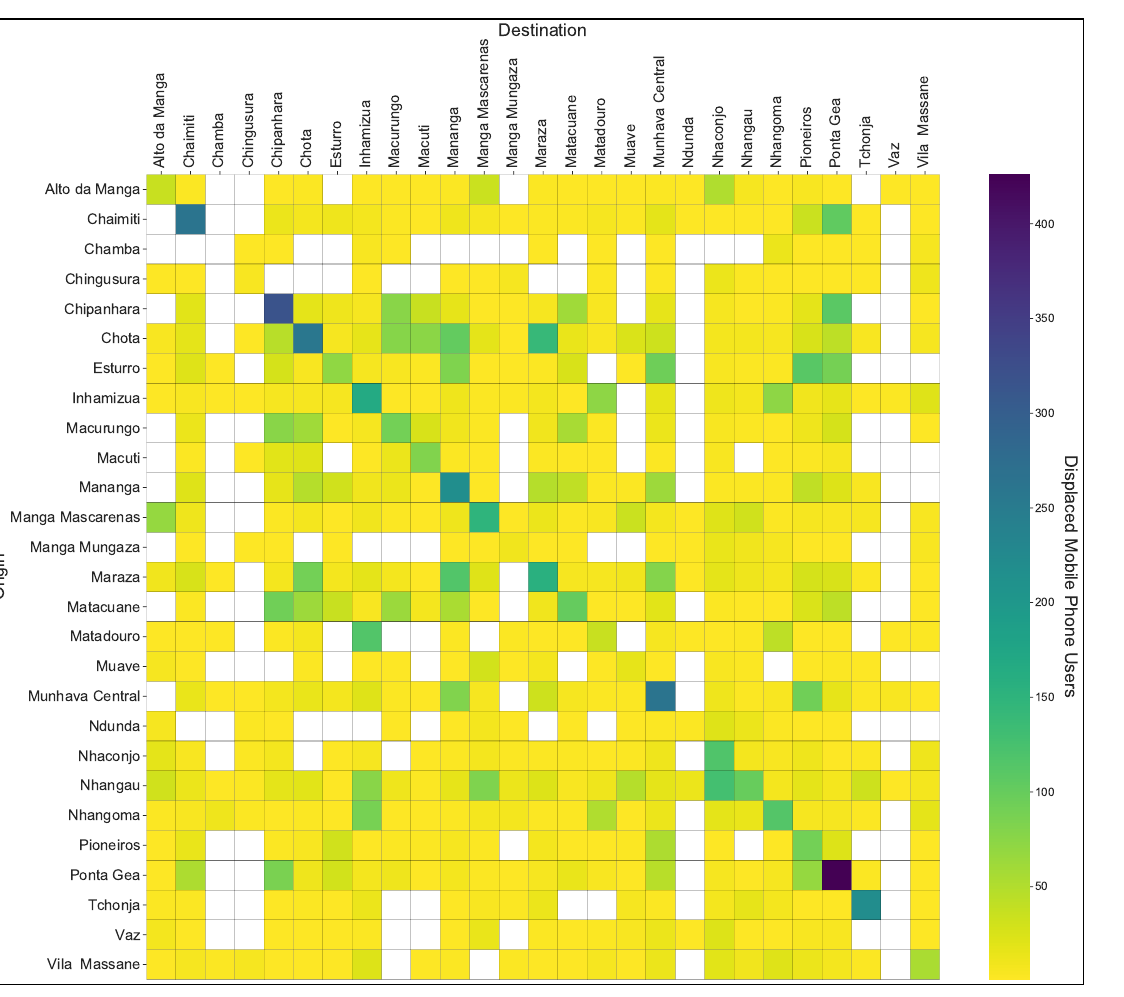
Figure 10. Mobile Phone Users Displacement